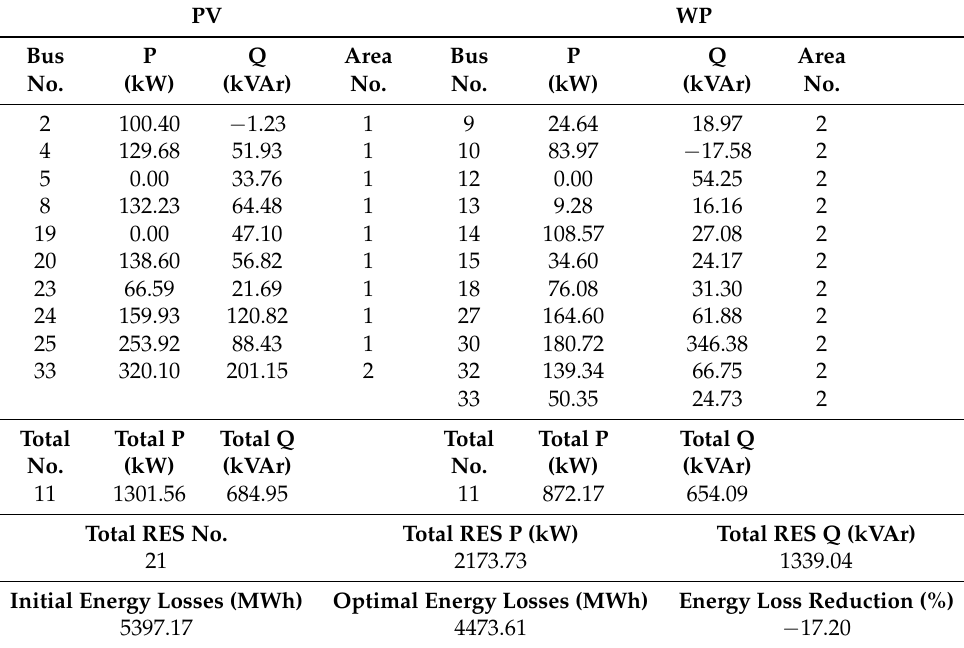
Table 15. Snapshot approach—50% value—Scenario #1.